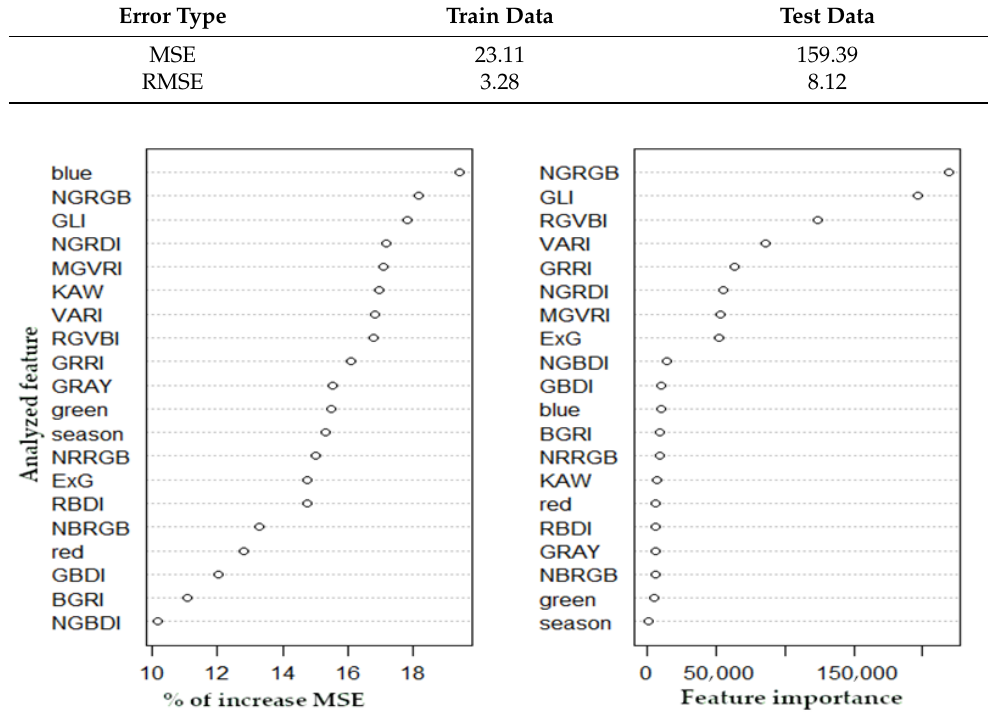
Figure 5. Compared performance between two linear models ( a ) model three and ( b ) model ten. The figure shows the relation between predicted (horizontal axis) versus actual phenology observation (vertical axis) between the training dataset (blue dots) and the test datasets (red dots). The fitted lines of the training data are in light blue, and the fitted line of the test data is in orange. Table 6. Performance of the random forest algorithm in training and test datasets.